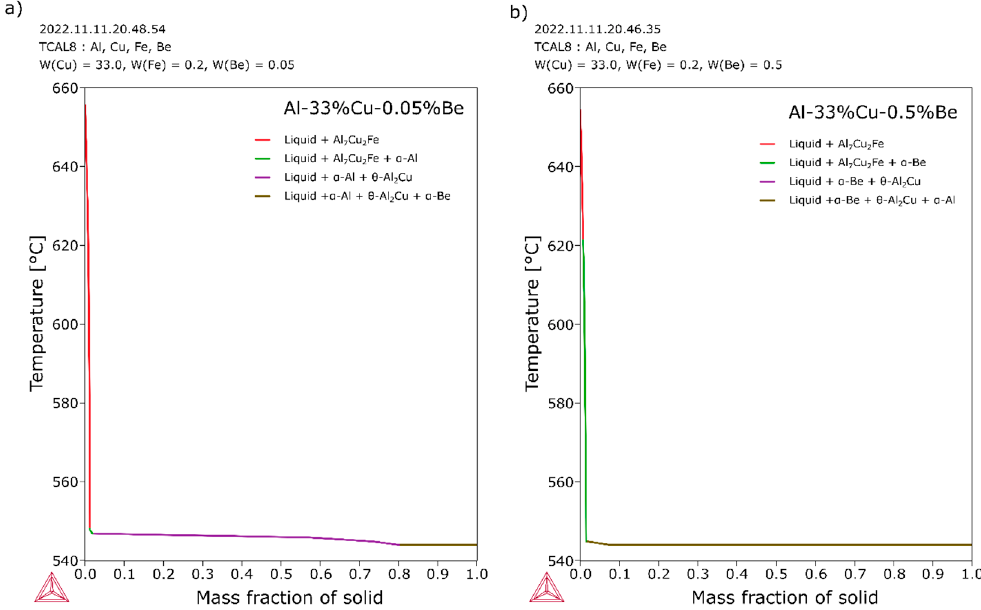
Figure 10. Solidification paths of ( a ) Al-33 wt.%Cu-0.05 wt.%Be and ( b ) Al-33 wt.%Cu-0.5 wt.%Be alloys simulated by the Thermo-Calc software based on the Scheil–Gulliver model. SEM-EDS analyses on transverse sections of Al-33 wt.%Cu-0.05 wt.%Be and Al-33